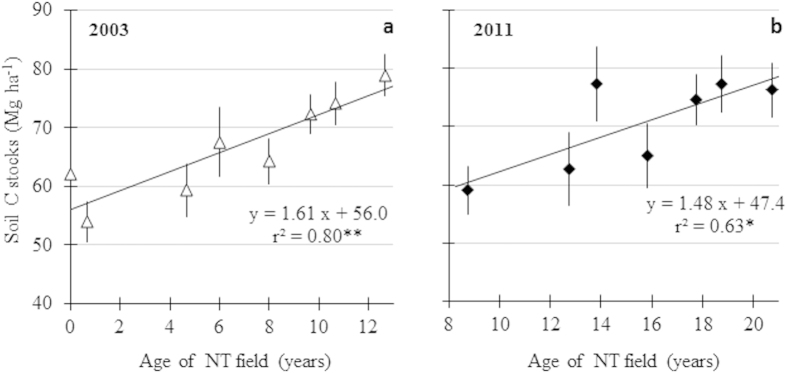
Synchronic assessment (2003 and 2011 sampling) of the mean annual soil C accumulation rates (0–40 cm) in the fields under NT cropping systems –including the CT field as reference in the 2003 sampling.**significant at P < 0.01; *significant at P < 0.05.